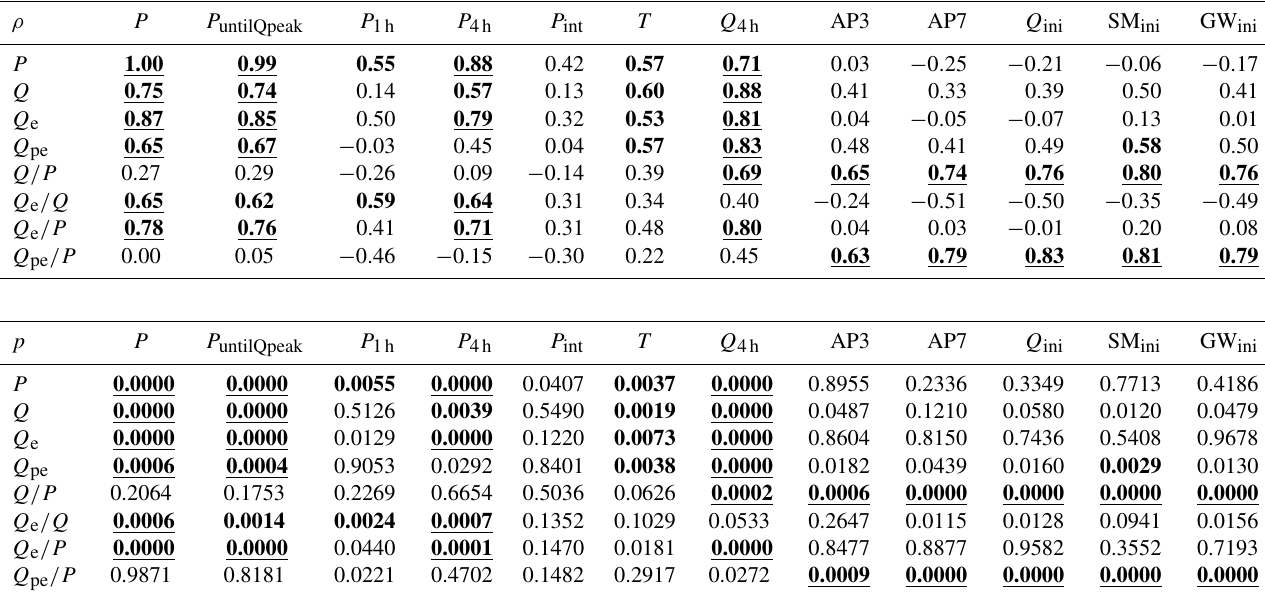
Table 3. Spearman rank correlation coefficients ( ρ ) and p values for measures of storm characteristics, antecedent wetness and catchment storm response. Bolded, underlined values represent statistically significant correlations with p< 0 . 0001, and bolded values represent sta- tistically significant correlations with p< 0 . 01. Measures of storm characteristics (left-hand columns in table) are total event precipitation ( P ), cumulative precipitation before peak flow ( P untilQpeak ), mean precipitation intensity ( P int ), maximum precipitation over 1h ( P 1h ) and 4h ( P 4h ), event duration ( T ), and 4h peak discharge volume ( Q 4h ). Measures of initial catchment wetness state (right-hand columns in table) are 3-day and 7-day antecedent precipitation (AP3 and AP7) as well as the 1h average values of discharge ( Q ini ), groundwater ta- ble depth (GW ini ), and soil moisture (SM ini ) before the onset of the storm event. Measures of catchment storm response (rows of table) are precipitation ( P ), discharge ( Q ), event discharge ( Q e ) and pre-event discharge ( Q pe ), all defined as totals over the event and ratios among them. Correlations are not shown for Q pe /Q , because they are just the negative of the corresponding correlations for Q e /Q (since Q pe /Q = 1 − Q e /Q